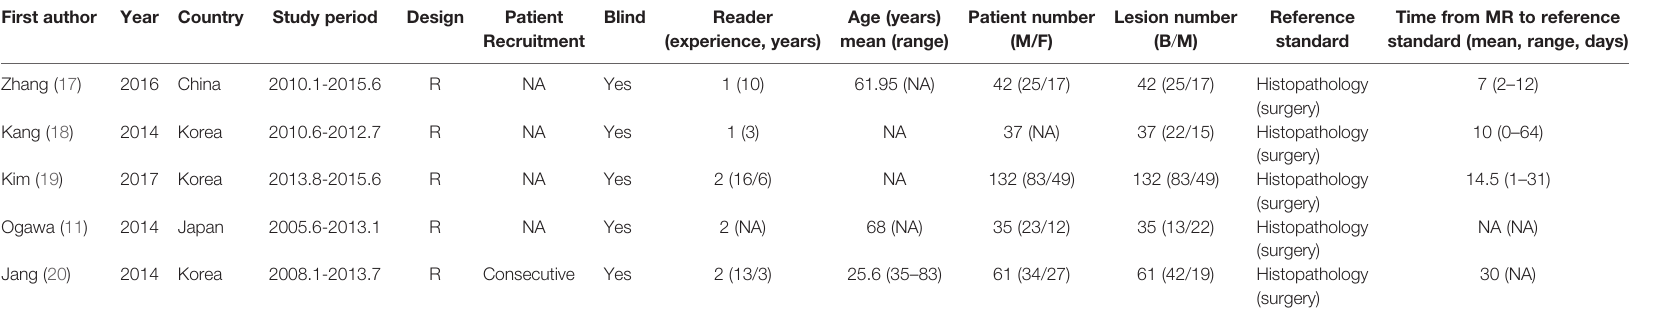
TABLE 1 | Study characteristics of the included studies.